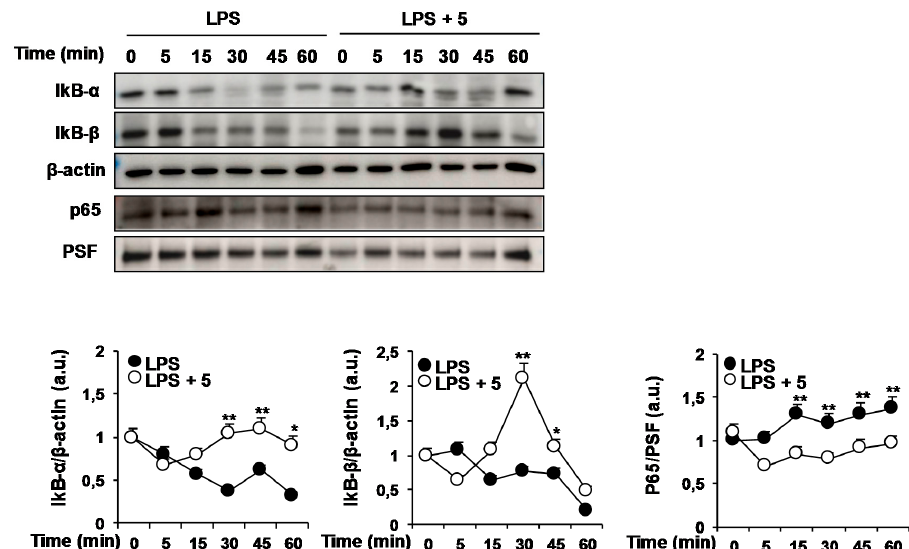
Figure 6. Diterpene 5 inhibits NF- κ B activation in LPS-stimulated murine macrophages. Macrophages were pretreated for 30 min with compound 5 (20 µ M) and then activated for the indicated times (5, 15, 30, 45, and 60 min) with 200 ng/mL LPS. The levels of proteins I κ B α , I κ B β , and p65 were determined by Western blot. β -actin and PSF were used as loading controls. A representative experiment is shown. Densitometry analysis shows the mean ± SD of three independent Western blot experiments. * p < 0.05, ** p < 0.01 vs. LPS.